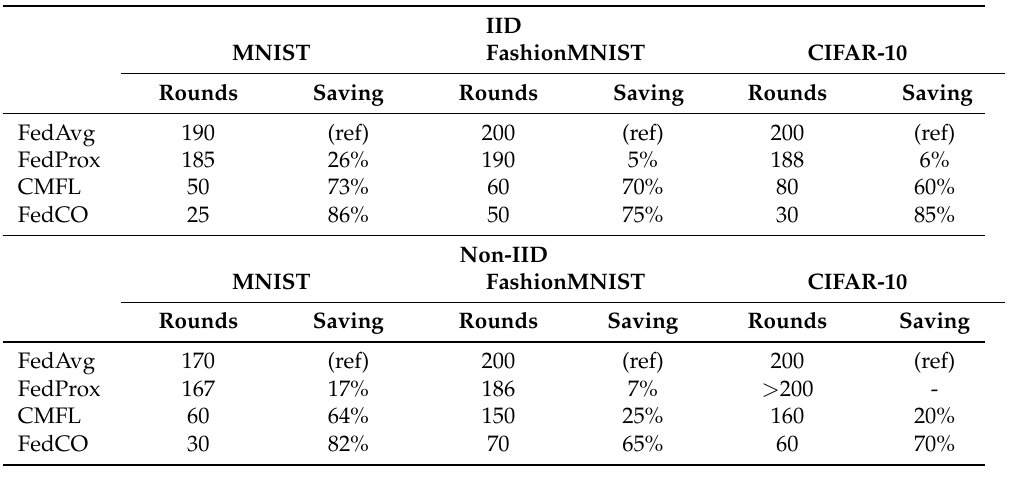
Table 4. The number of communication rounds to reach a target accuracy for the three compared FL algorithms.